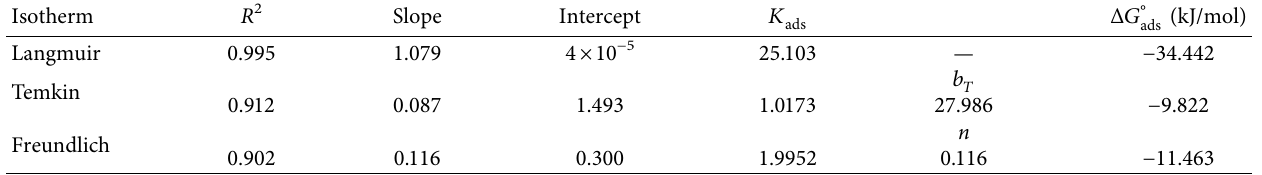
Table 4: Parameters derived from adsorption models and coefficients of determination at 293K.